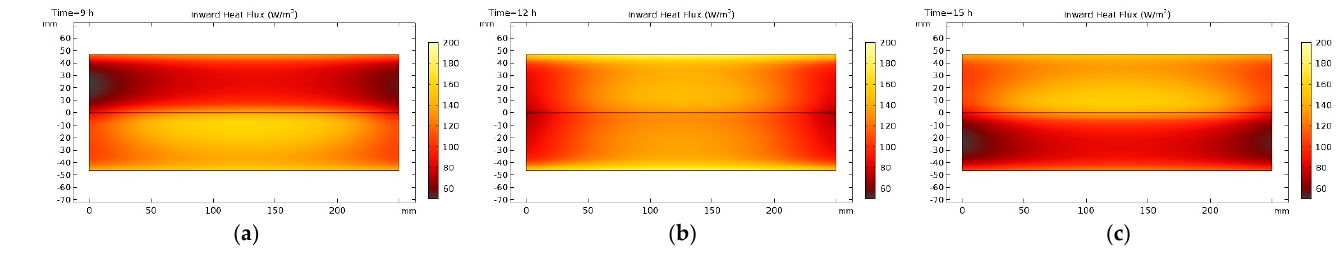
Figure 10. Surface plot of the inward heat flux through the projected area of the lower surface of the triangular SHC with a reflector at ( a ) 9:00; ( b ) 12:00; and ( c ) 15:00 on 1 July 2022.